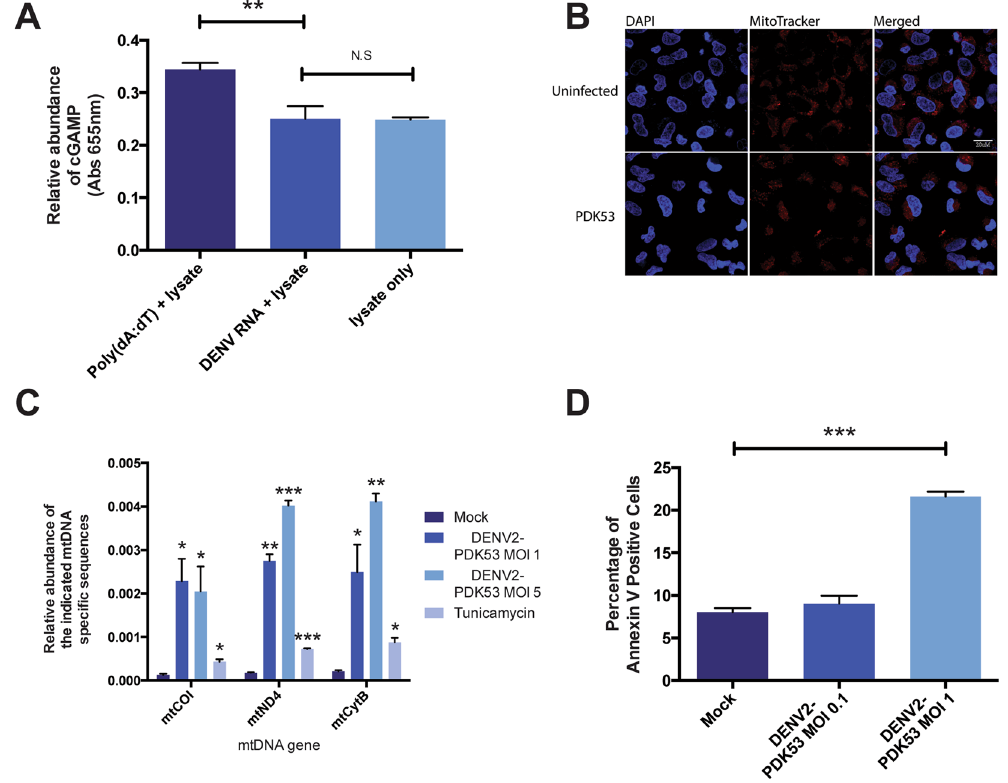
Figure 3. DENV infection activates cGAS through the release of mtDNA into the cytosol. ( A ) cGAMP activity measured in A549 lysates incubated with 1 μ g/ml DENV-derived RNA or 1 μ g/ml poly(dA:dT). ( B ) Cellular localization of mitochondria (red) in A549 cells infected with DENV2-PDK53 at MOI 1 for 72 hrs. ( C ) Fold induction of levels of mitochondria-specific DNA sequences mtCOI , mtND4 , and mtCytB present in the cytosol of A549 cells infected with DENV2-PDK53 at MOI 1 and MOI 5 or treated with 4 μ g/ml tunicamycin. ( D ) Percentage of Annexin V positive cells in A549 cells infected with DENV2-PDK53 at MOI 0.1 or MOI 1 for 48 hrs, assessed by flow cytometry. In this figure, * depicts P < 0.05; ** depicts P < 0.01 and *** depicts P <